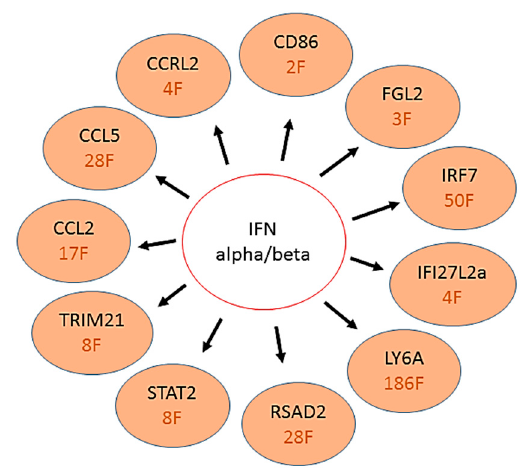
Figure 6. Schematic showing IFN- α / β activation and induction of related ISGs or IFN regulators in CSCs. The red text indicates fold (F) upregulation.